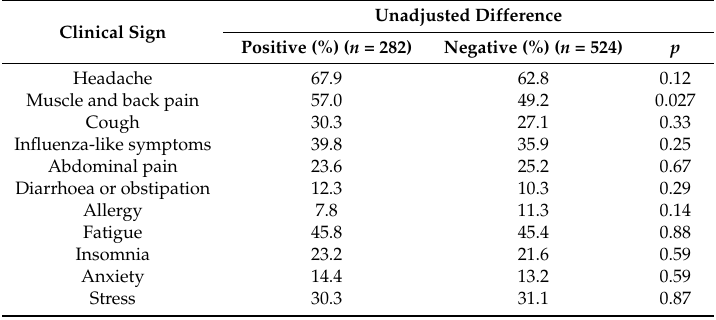
Table 4. Occurrence of clinical symptoms in persons seropositive and seronegative to T. gondii. Clinical